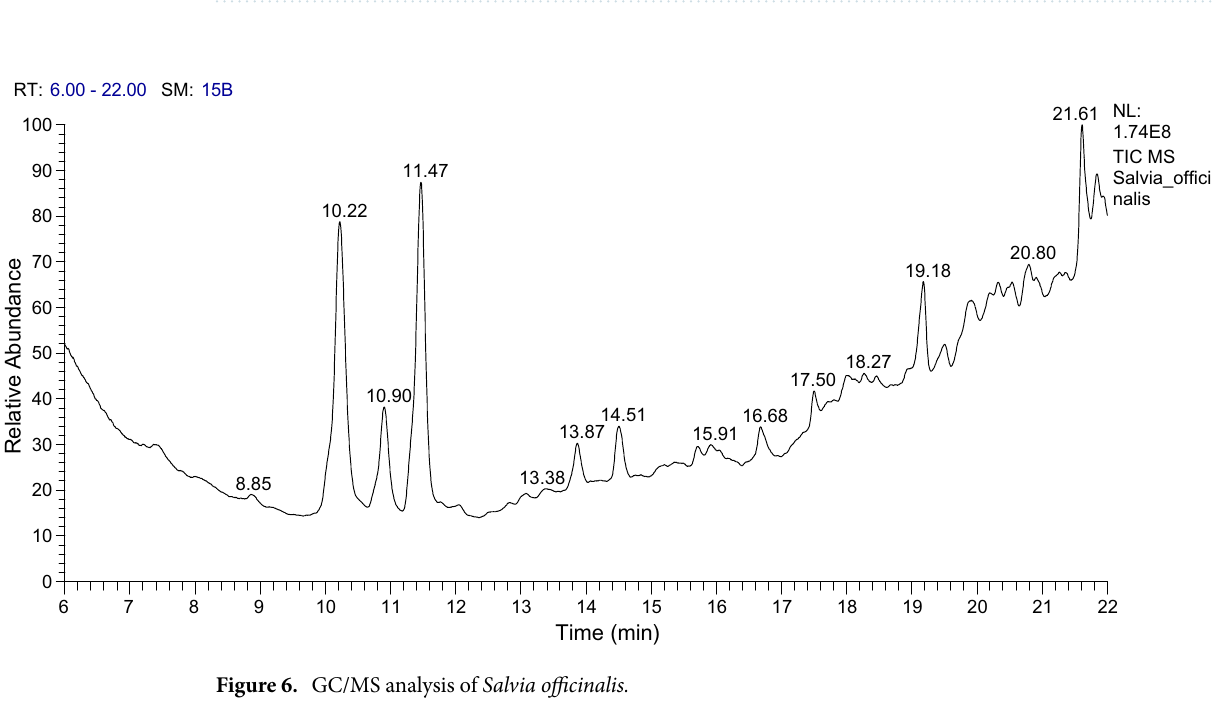
Table 12. GC/MS analysis of the Salvia officinalis.